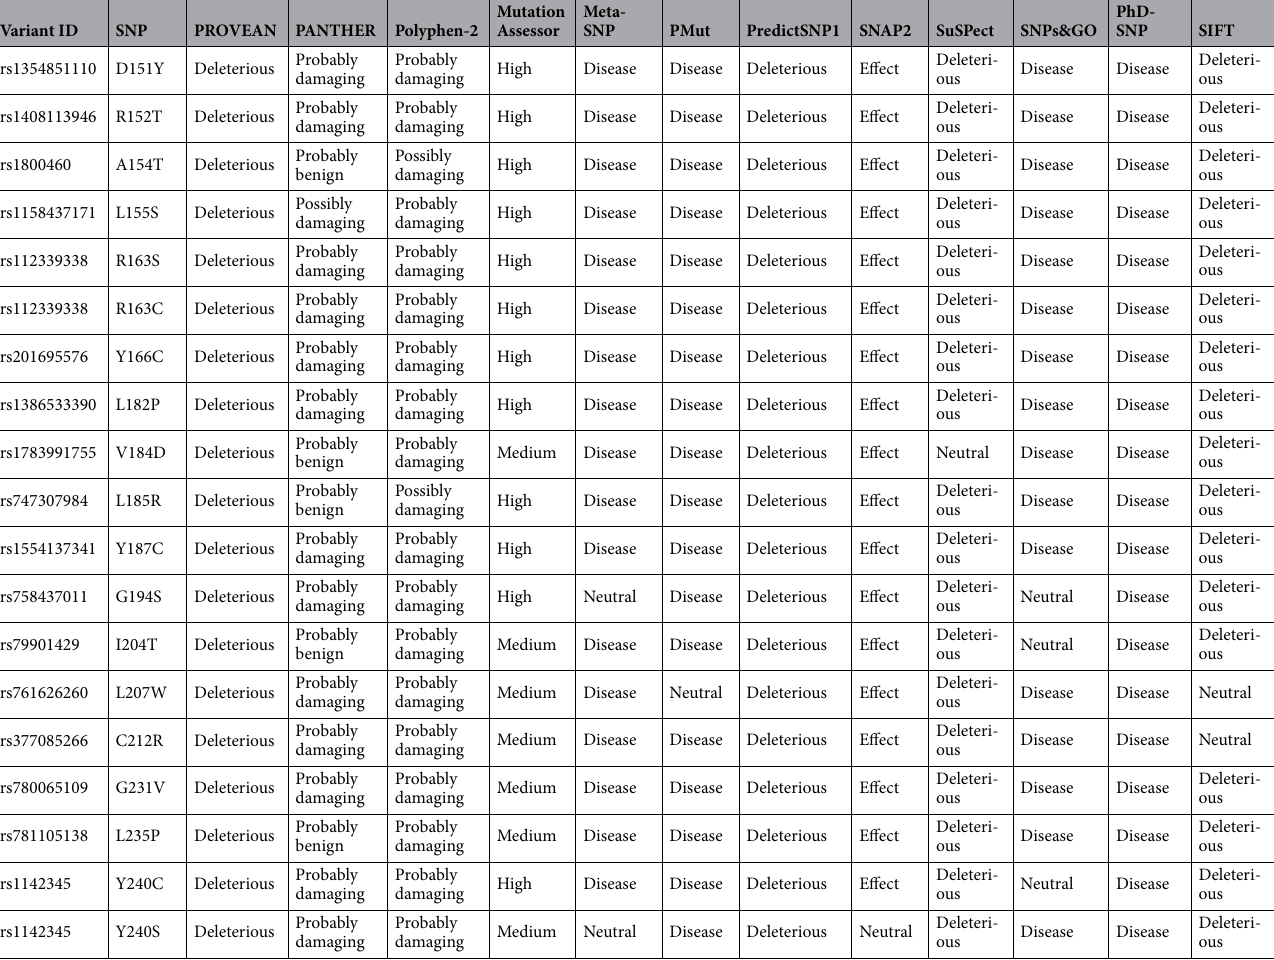
Table 1. List of missense nsSNPs predicted to be deleterious by at least nine out of 12 sequence-based tools.